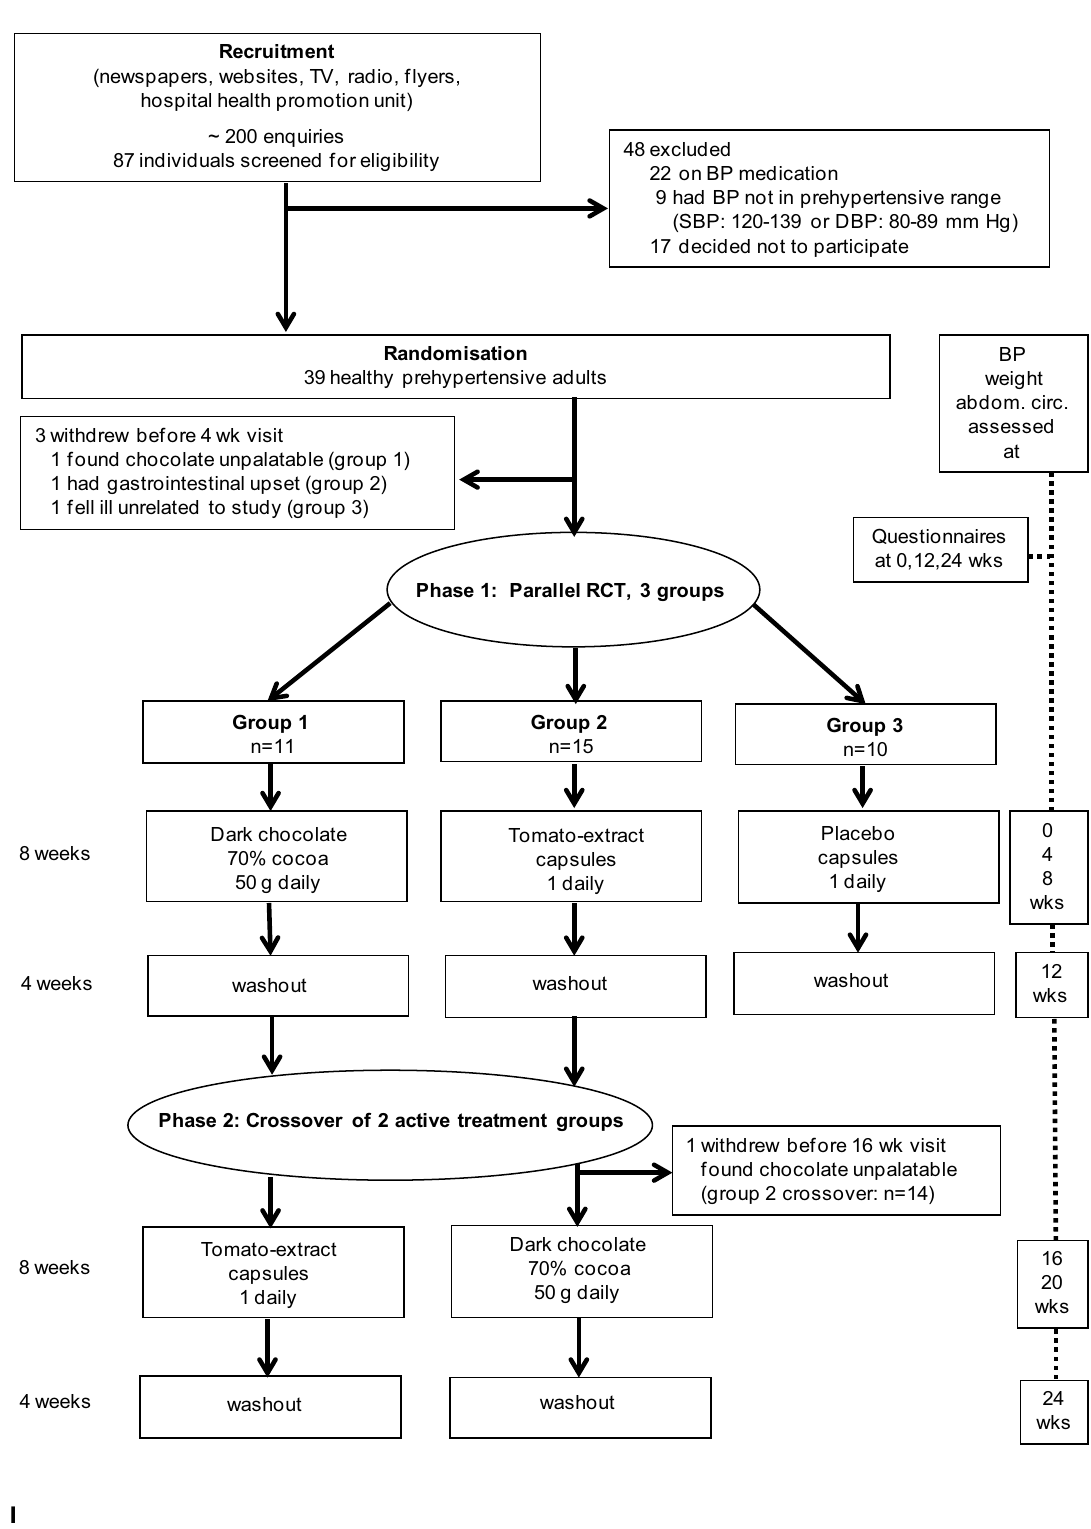
Trial flow Figure 1 Trial flow